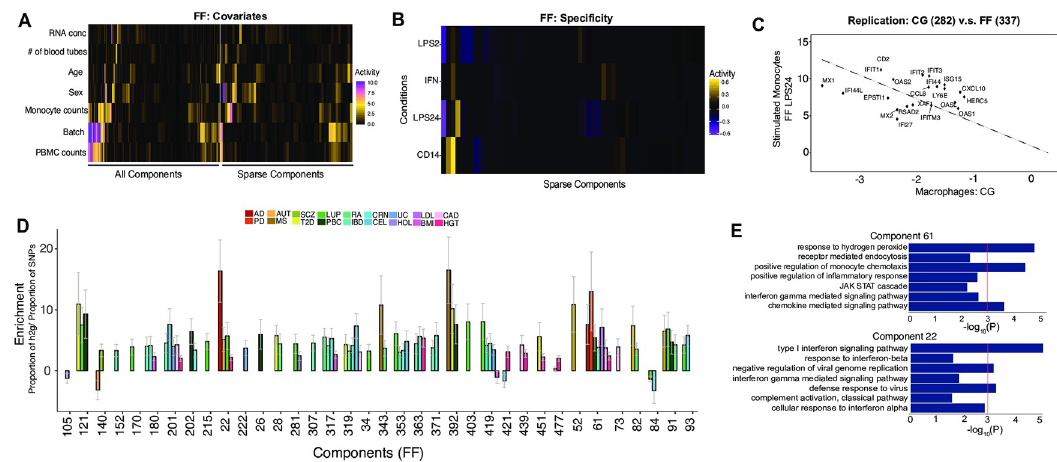
Fig 2. Discovery and reproducibility of sparse components enriched for disease heritability. (A) Heat map of known covariates and correlation with individual scores from each of the 500 components (left) and 56 sparse components (right) in FF data. (B) Heat map of condition specificity scores for the sparse components in FF data. Each row is a stimulation (na ï ve, LPS, or IFN) and each column is a sparse component. (C) Component replication between component 282 (CG) and component 337 (FF LPS24) for the most highly scored genes. The gene scores from the two components (in CG and FF) are highly correlated. (D) Proportion of heritability for 18 selected complex traits that can be attributed to each sparse component from the FF data. Shown here are enrichment statistics (with standard error) comparing the proportion of SNP heritability within the components divided by the proportion of total SNPs represented at FDR-corrected P < 0.05. (E) Gene Ontology (GO) enrichment for genes in component 61 and 22. AD: Alzheimer’s disease; PD: Parkinson’s disease; AUT: Autism; MS: Multiple Sclerosis; SCZ: Schizophrenia; T2D: Type 2 Diabetes; LUP: Lupus; PBC; Primary Biliary Cirrhosis; RA: Rheumatoid Arthritis; IBD: Inflammatory Bowel Disease; CRN: Crohn’s Disease; CEL: Celiac Disease; UC: Ulcerative Colitis; HDL: High-density lipoprotein Cholesterol; LDL: Low-density lipoprotein Cholesterol; BMI: Body Mass Index; CAD: Coronary Artery Disease; HGT: Height.